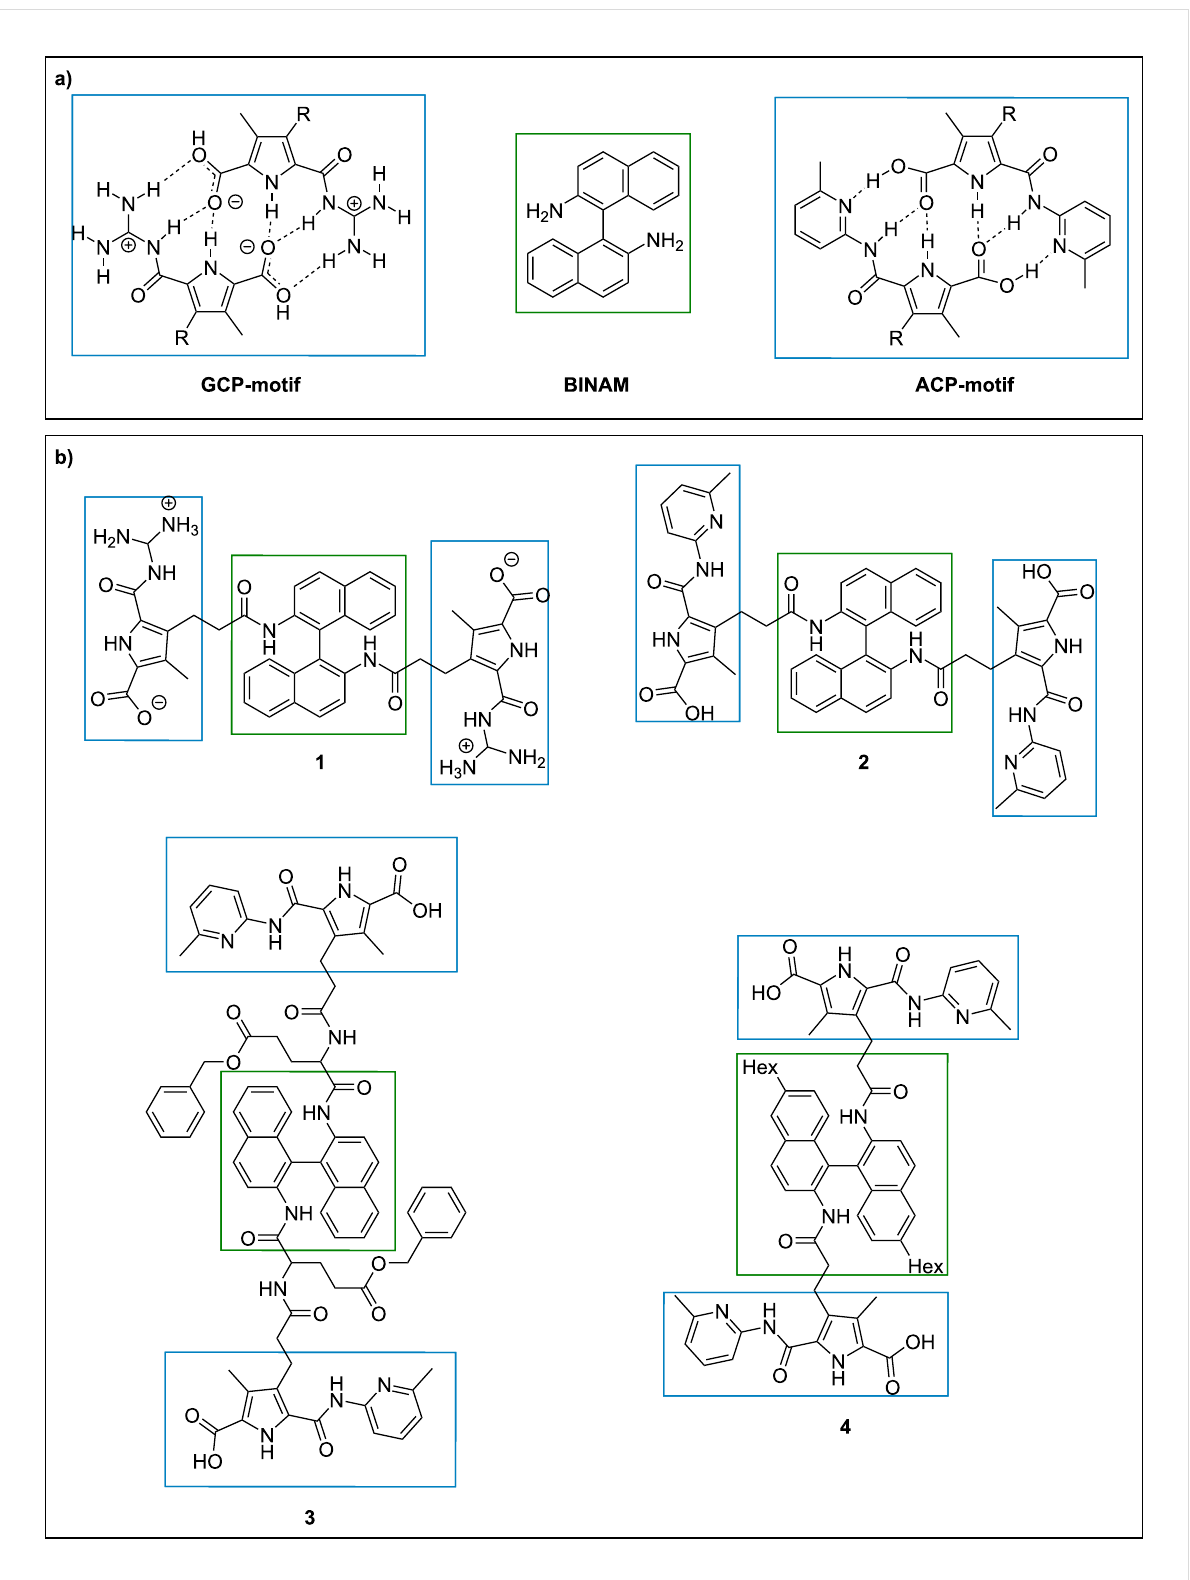
Figure 2: a) GCP and ACP motif, as charged and neutral BUs and BINAM as precoordinating LU. b) Compounds 1 , 2 , 3 and 4 are based on the com- bination of BINAM with the GCP or ACP motif,